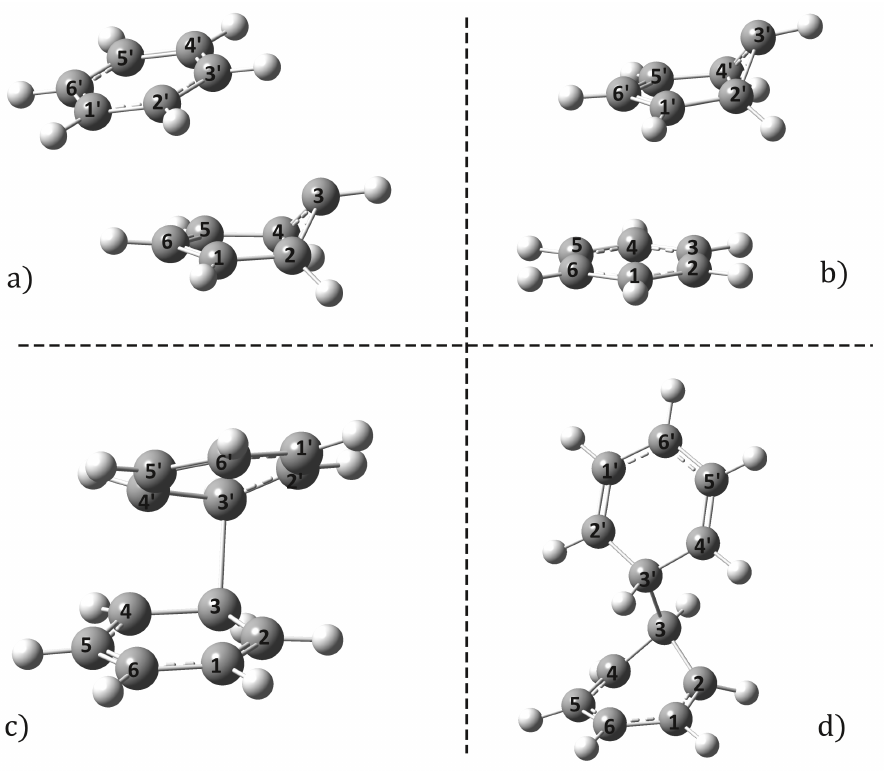
Figure 2. Conical intersection geometries of benzene dimer for monomer- (( a ) CI M (I) and (( b ) CI M (II)) as well as for dimer-type (( c ) CI D (I) and (( d ) CI D (II)) configurations computed at the spin-flipped TDDFT level of theory by considering the ω B97X-D3/ma-def2-TZVPP computation